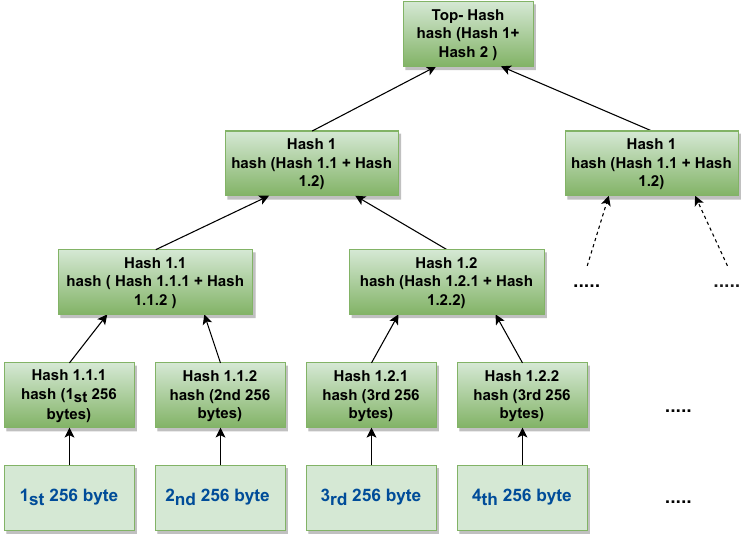
Figure 8. Merkle